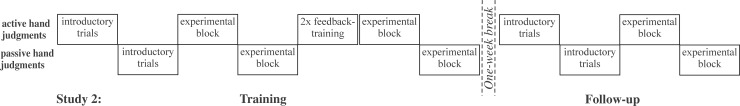
Experimental procedure in Study 2.In the experimental judgment blocks participants had to judge whether their hand may fit into a given opening. Only in feedback blocks participants had to actually try to fit their hand into the opening (training). One week after training a follow-up testing was conducted.